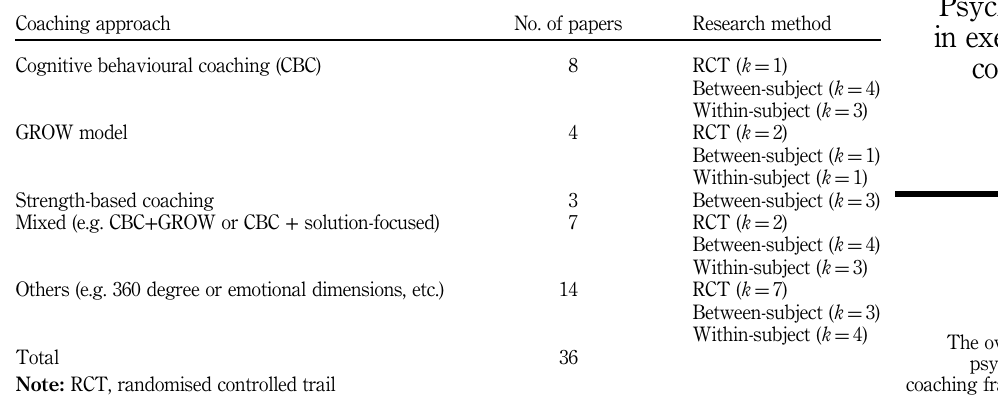
Table I. The overview